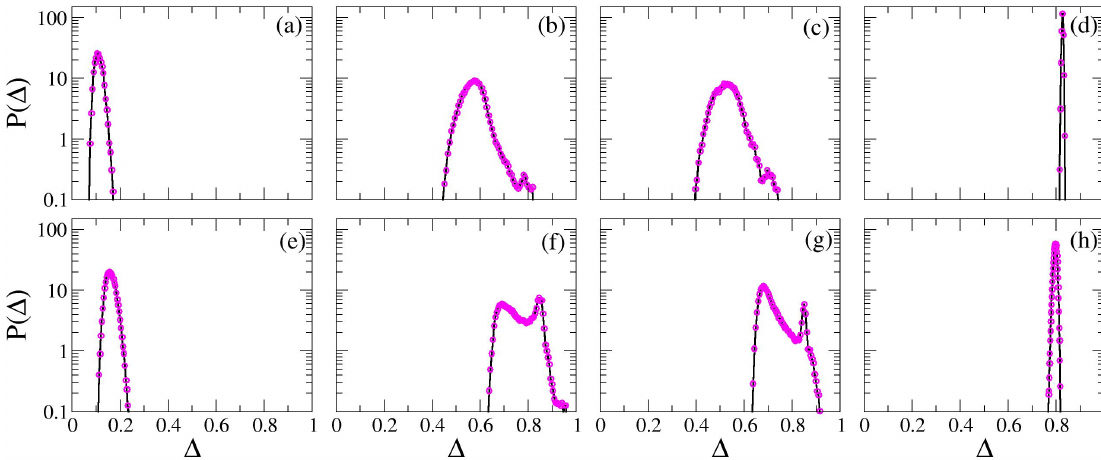
Figure 9. Probability distribution functions (PDFs) from the determinism time series ( ∆ ) depicted in Figure 8. The panels follow the same scheme as in Figure 8, where the first row refers to the scale-free network, and the second row refers to the small-world network. In the transition region, the distribution is not symmetric and indicates a non-stationary behavior; however, only in the small-world case is the existence of two states